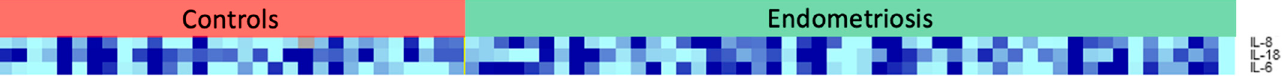
Figure 2. Heat map representing the target proteins that showed a significantly different concentration in peritoneal fluid of patients with endometriosis (patients with DIE and patients with endometriosis without DIE) compared to controls. The color intensity correlates with the expression level of the protein.